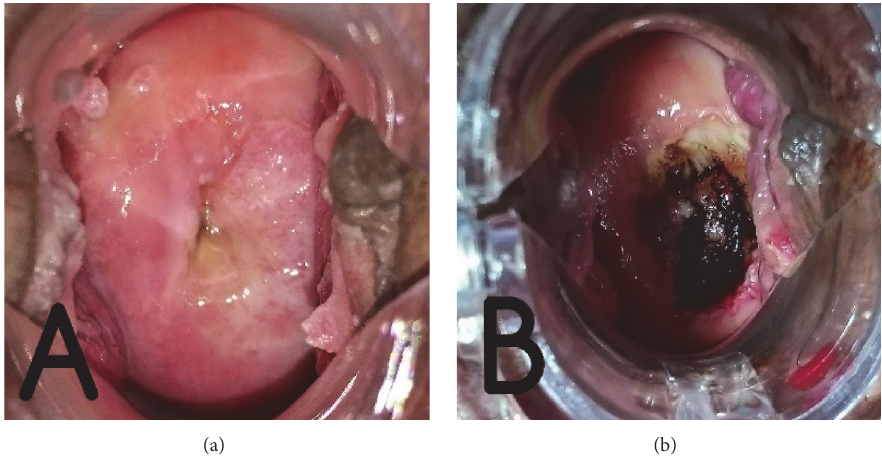
Figure 3: (a) Recurrence of condyloma acuminata in cervical region (b) after surgical